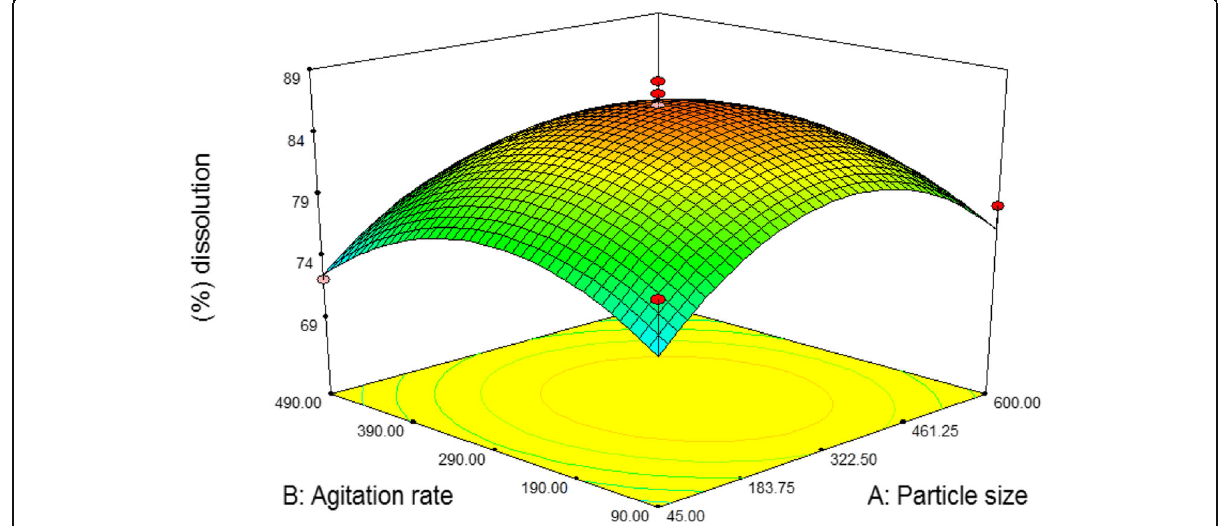
Fig. 14 Interactive 3D response surface plot for ore particle size and agitation